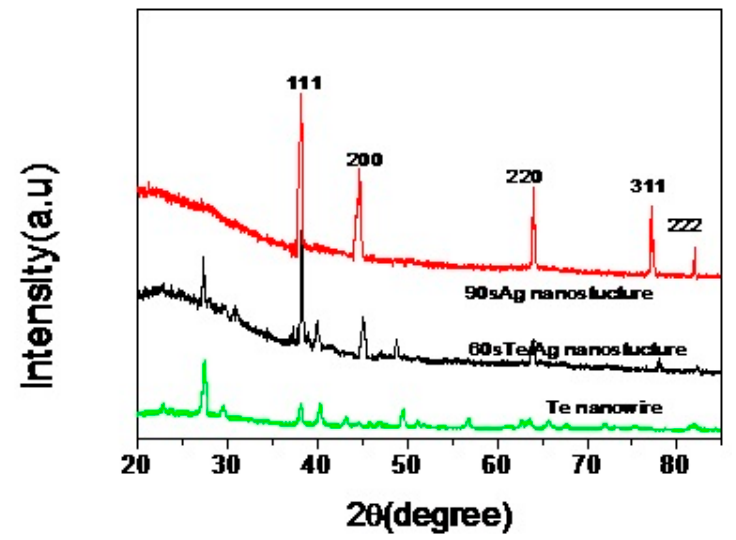
Figure 2. XRD patterns of branch-trunk Ag hierarchical nanostructures generated at different reaction time.